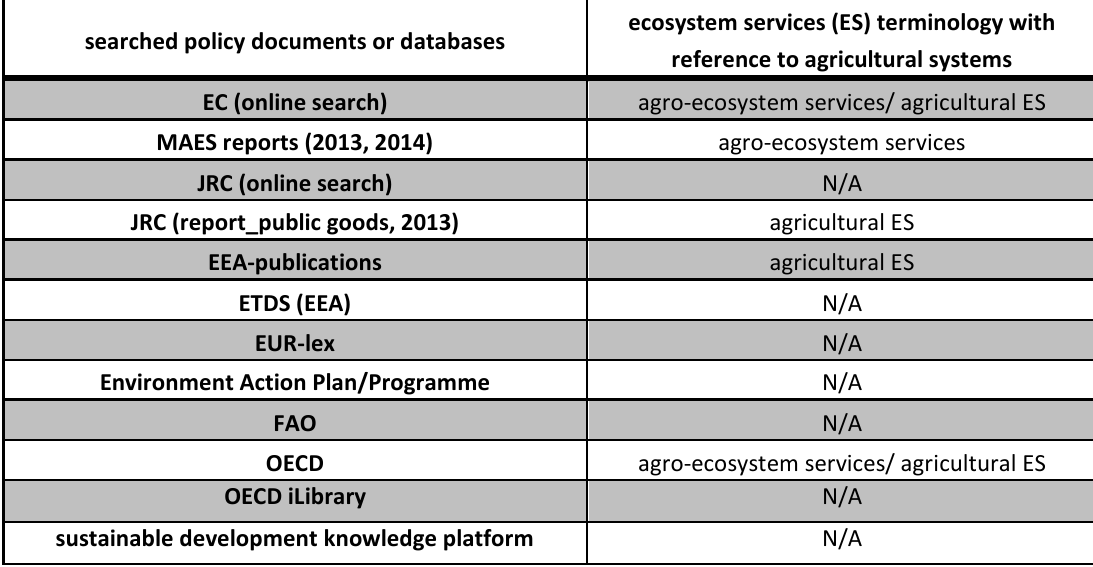
Table 2: Results of the terminologically mining of the political context on a European (lines 1-8) and on a global level (lines 9-12). For the definitions of abbreviations, see methods section 1.2.